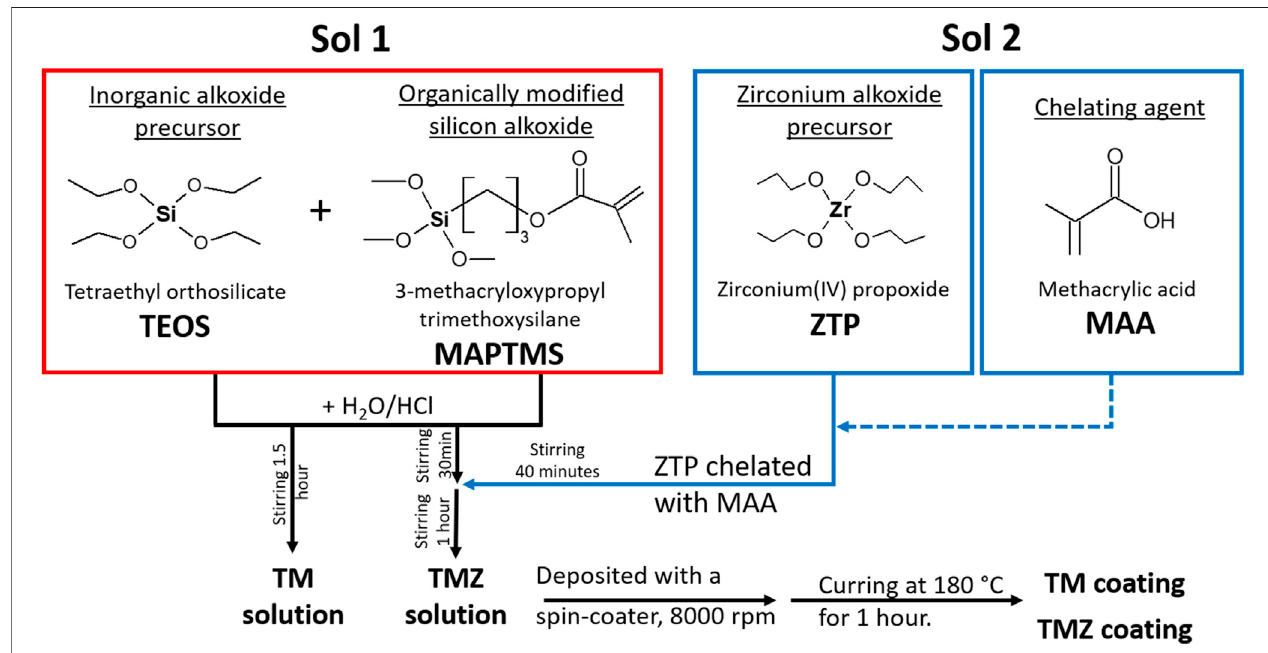
FIGURE 1 | Flow chart of the sol-gel solution preparation of TM sol (Sol 1) and TMZ sol (Sol 1 + Sol 2) and coating deposition on the aluminium substrate.